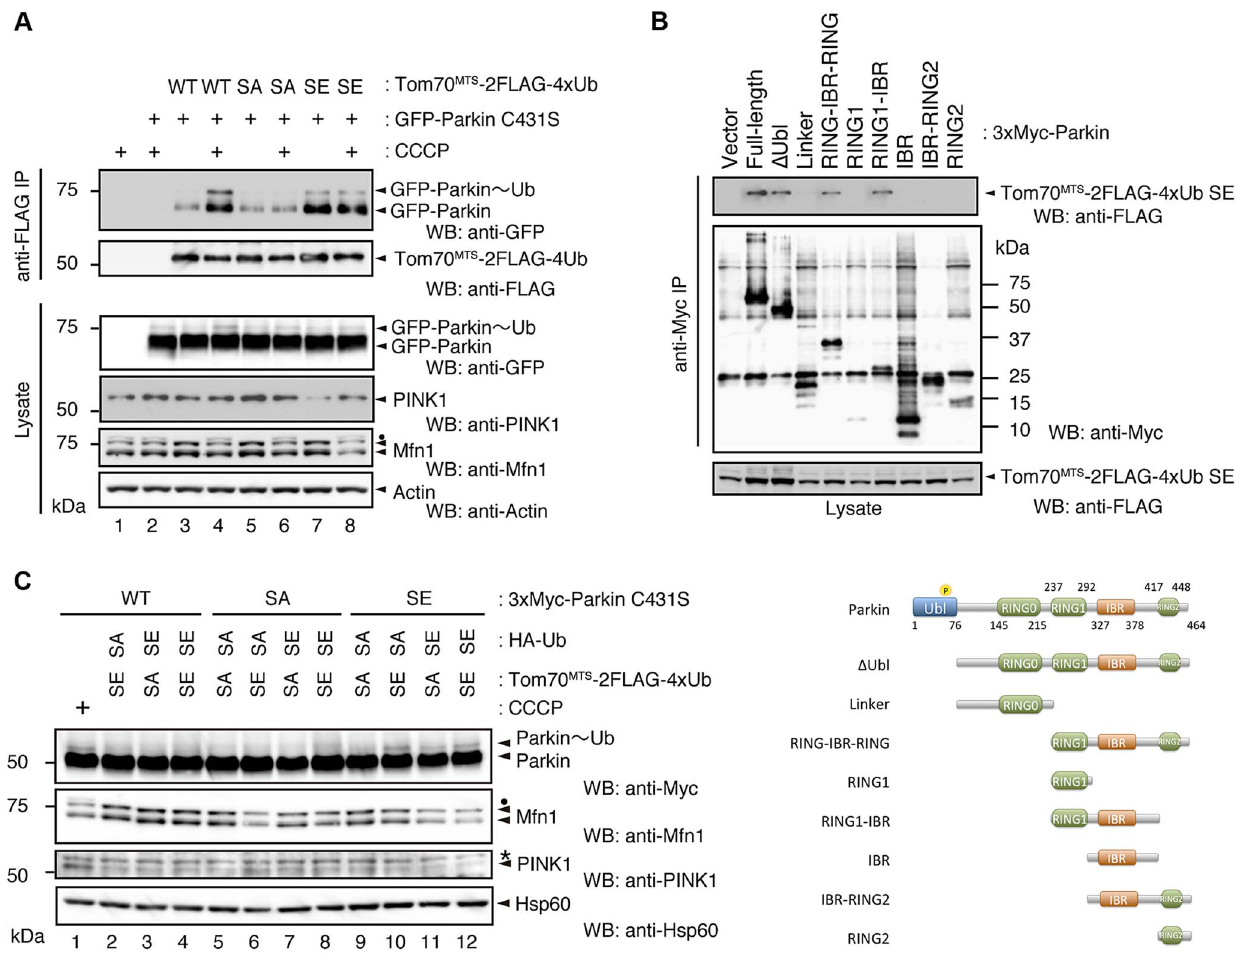
Figure 5. Phosphorylation of the polyUb chain activates Parkin E3 activity. ( A ) The Ub SA mutation attenuates the CCCP-dependent Parkin- polyUb association, whereas the Ub SE mutation promotes this association. HEK293T cells were transfected with the indicated combination of plasmids and were then treated with 10 m M CCCP for 1 hr. Tom70 MTS -2FLAG-4Ub constructs (WT, SA and SE) were immunoprecipitated with anti- FLAG beads and eluted with 100 m g/ml 3xFLAG peptide. Coprecipitated GFP-Parkin was detected by western blot. Note that the expression of Tom70 MTS -2FLAG-4Ub SE alone did not lead to PINK1 accumulation (lane 7). The dot indicates putative ubiquitinated Mfn1. ( B ) Parkin associates with Tom70 MTS -2FLAG-4Ub SE through its RING1-IBR. HEK293T cells were transfected with a series of 3xMyc-tagged full-length Parkin and its mutants together with Tom70 MTS -2FLAG-4Ub SE. Coprecipitated Tom70 MTS -2FLAG-4Ub SE was detected with an anti-FLAG antibody. Diagram of the Parkin deletion mutants used in this experiment is shown at the bottom. ( C ) Phosphomimetic Parkin SE is activated by either cytosolic SE Ub or the mitochondrial SE polyUb chain. Note that the accumulation of PINK1 and obvious degradation of Mfn1 were not observed, even with a combination of HA-Ub SE and Tom70 MTS -2FLAG-4xUb SE (lane 12 vs. lane 1). The dot and the asterisk indicate putative ubiquitinated Mfn1 and non-specific signals, respectively.